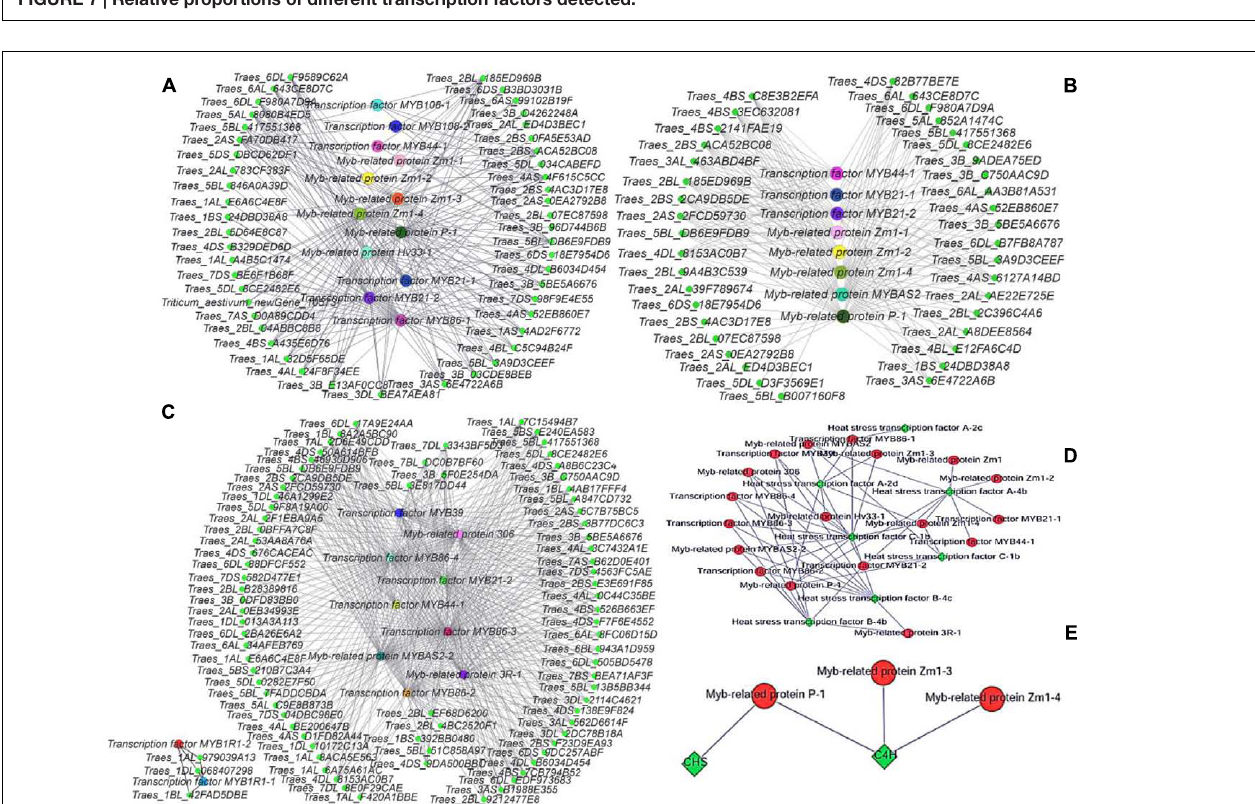
FIGURE 8 | Gene interaction network diagrams. (A) Interactions between MYB genes and other genes in the late uninucleate stage. (B) Interactions between MYB genes and other genes in the binucleate stage. (C) Interactions between MYB genes and other genes in the trinucleate stage. (D) Interactions between heat stress genes and other genes. (E) Interactions between MYB genes with CHS and C4H genes. In (A–C) green represents genes that interact with MYB genes, and each of the other colors represents one type of MYB gene. The protein names are shown for the corresponding